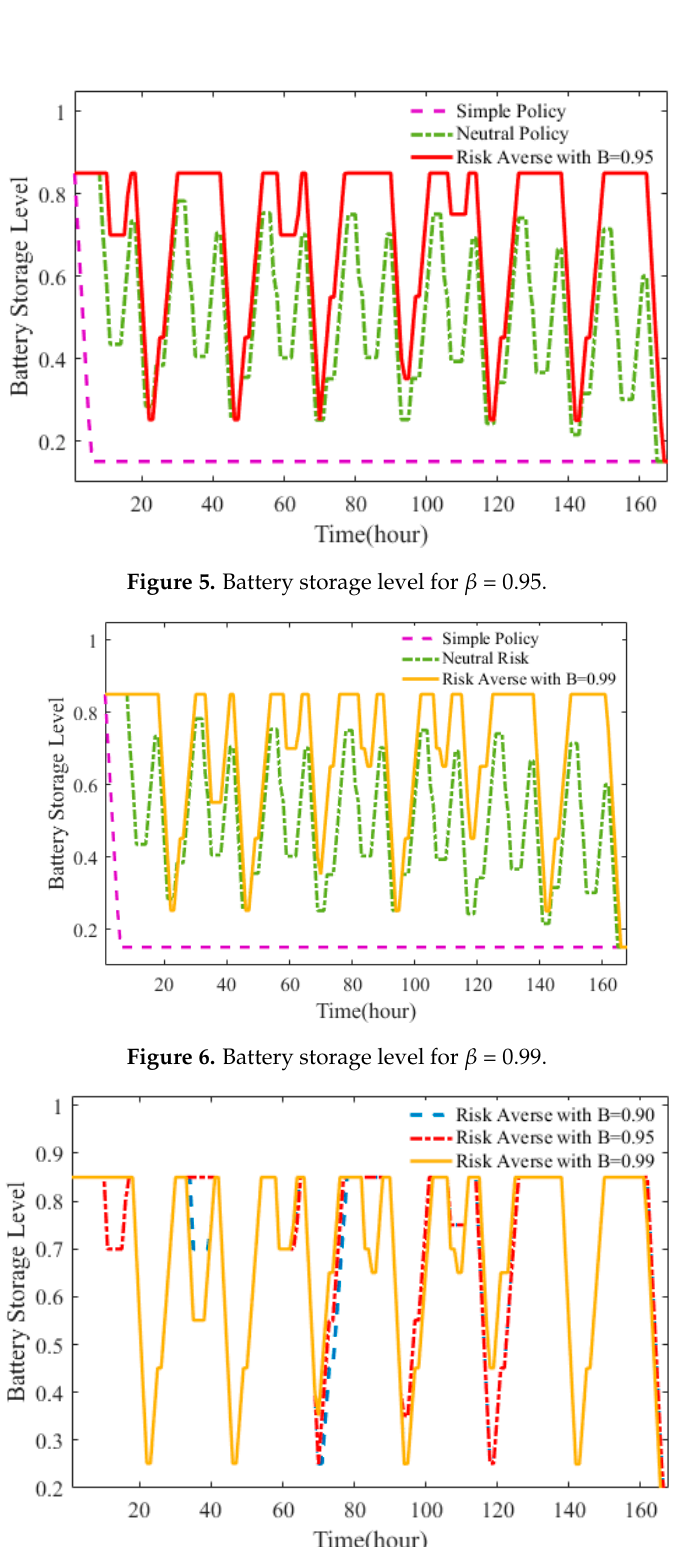
Figure 4. Battery storage level for β = 0.9.